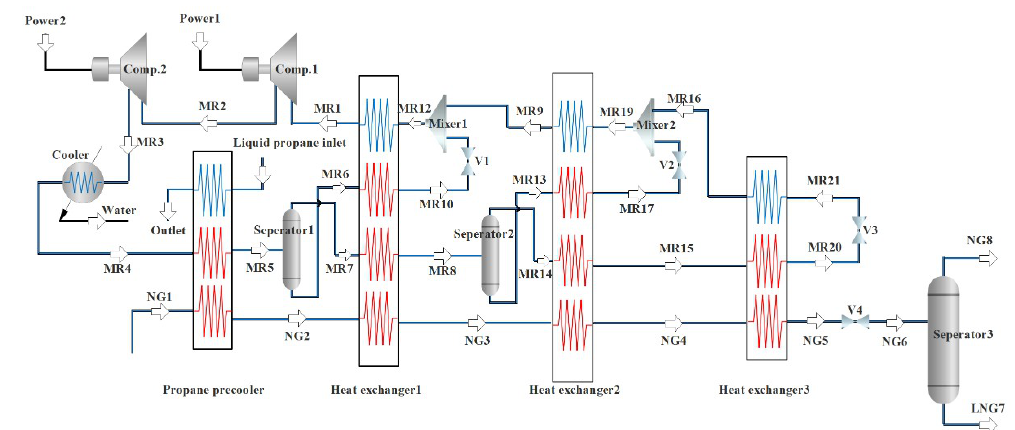
Figure 2. Flow chart of NG liquefaction with propane pre-cooled mixed refrigerant.